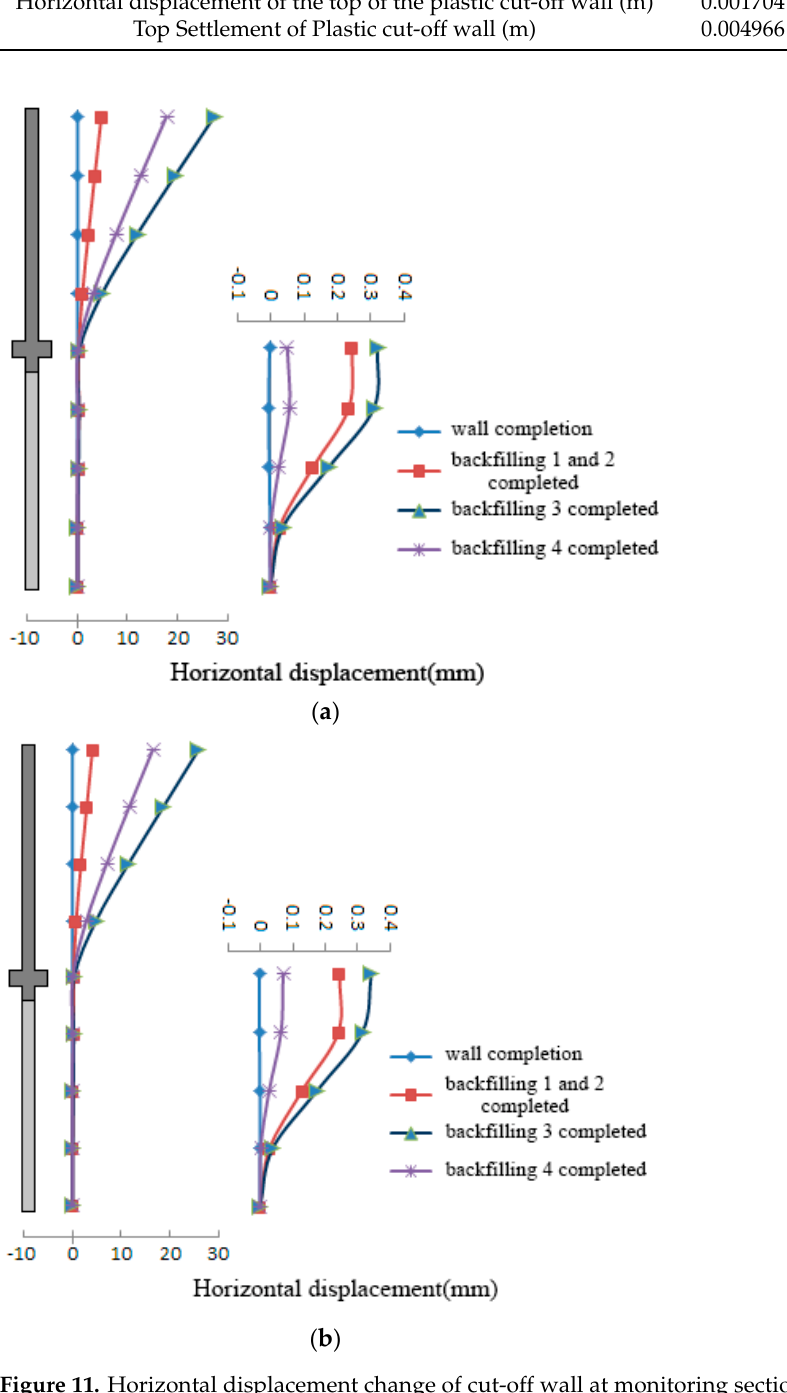
Figure 11. Horizontal displacement change of cut-off wall at monitoring section. ( a ) Monitoring 1 section cut-off wall. ( b ) Monitoring 2 section cut-off wall.